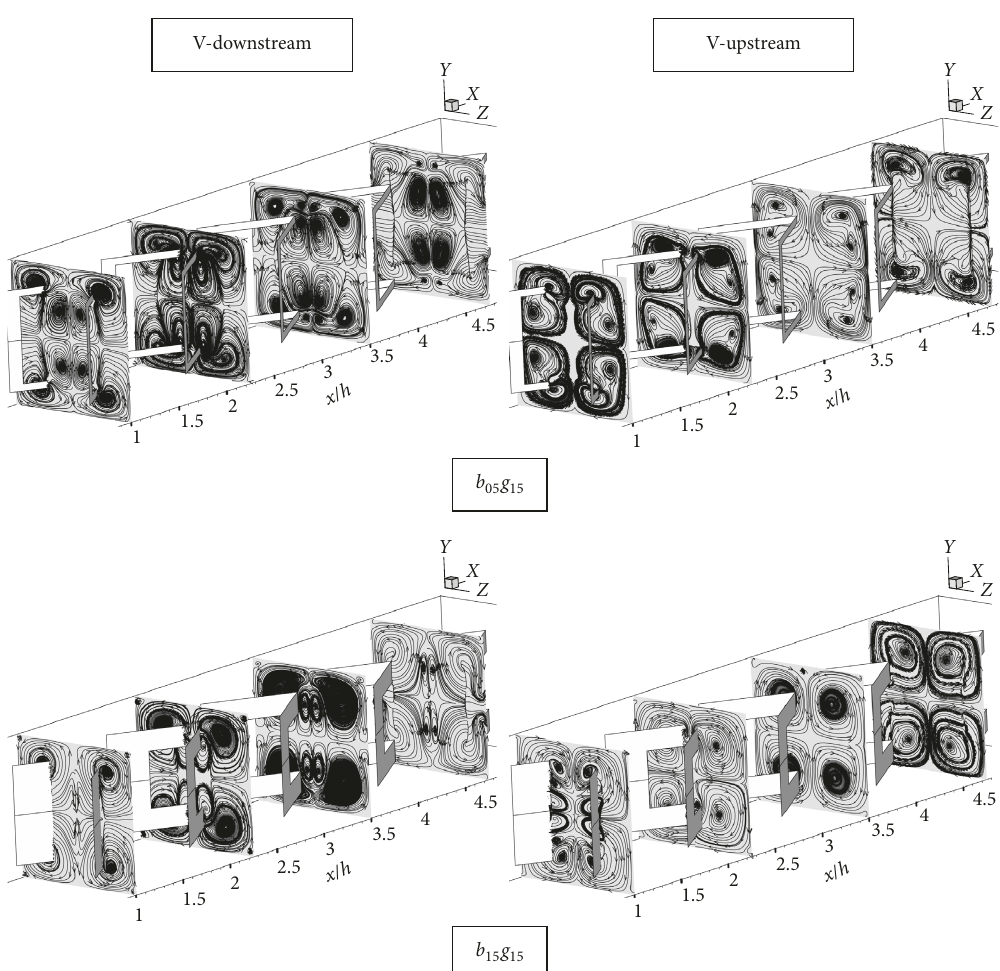
Figure 7: Streamlines in transverse planes for the square channel heat exchanger installed with V-orifice at various blockage ratios and flow direction for Re 600 and V-downstream (cid:31)